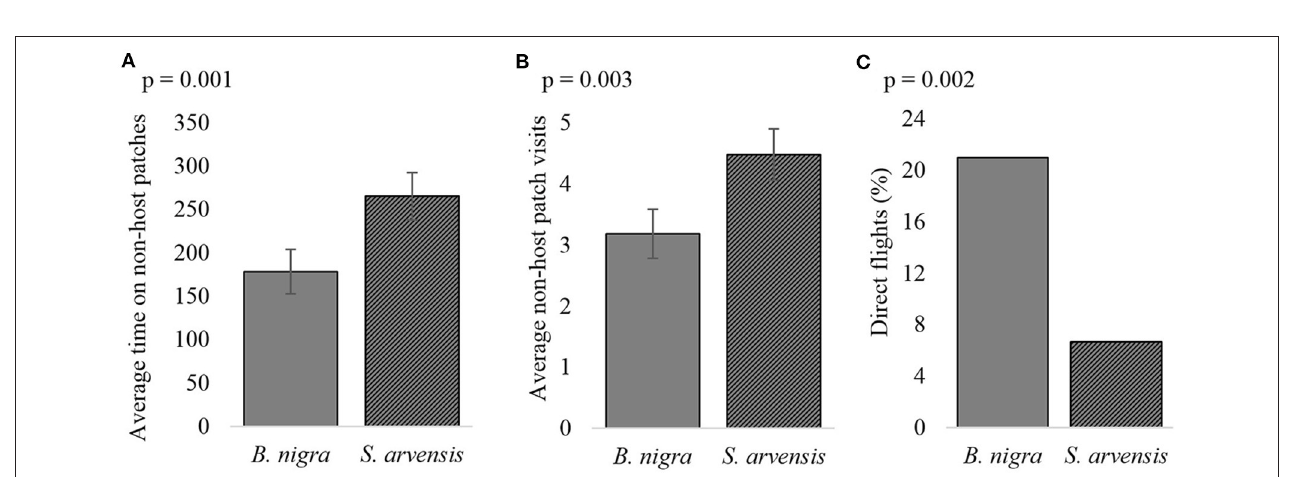
FIGURE 6 | Wasp behavior under different foraging situations: (A) average non-host patch visits, (B) the percentage of wasps responding to the HIPVs in the wind tunnel. Bars with different letters are significantly different ( α = 0.05), error bars show the s.e.